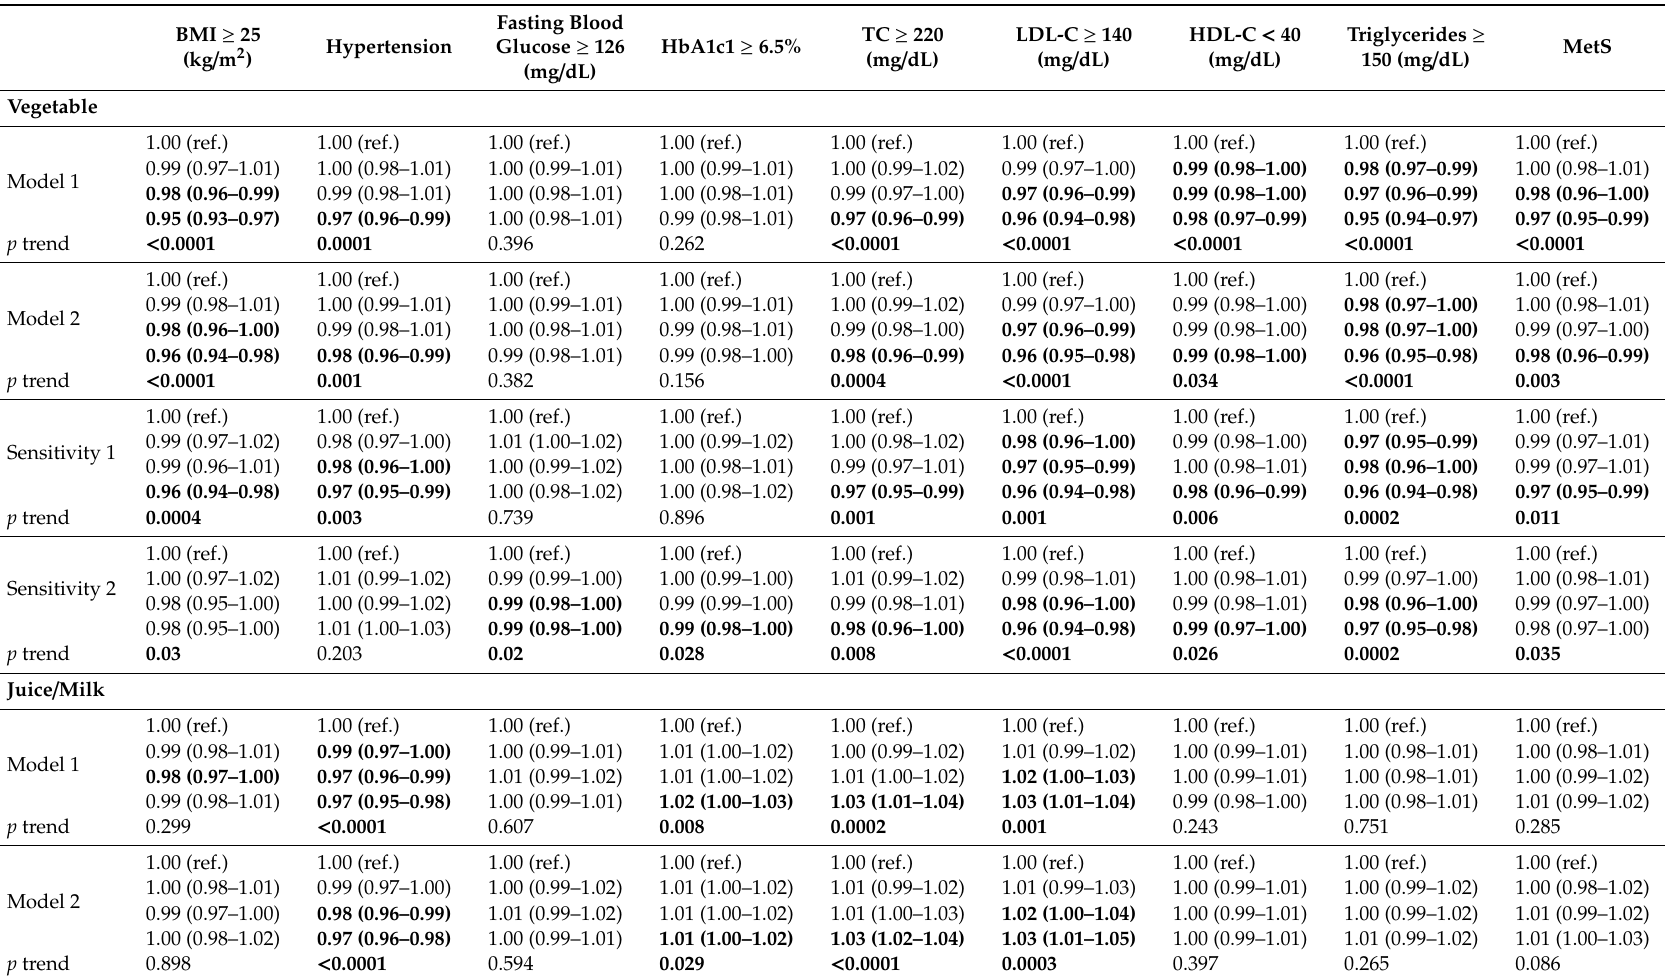
Table 5. Prevalence ratios (PRs, 95% CIs) for cardiometabolic factors in 2015 by quartiles of dietary pattern scores during 2011–2013,